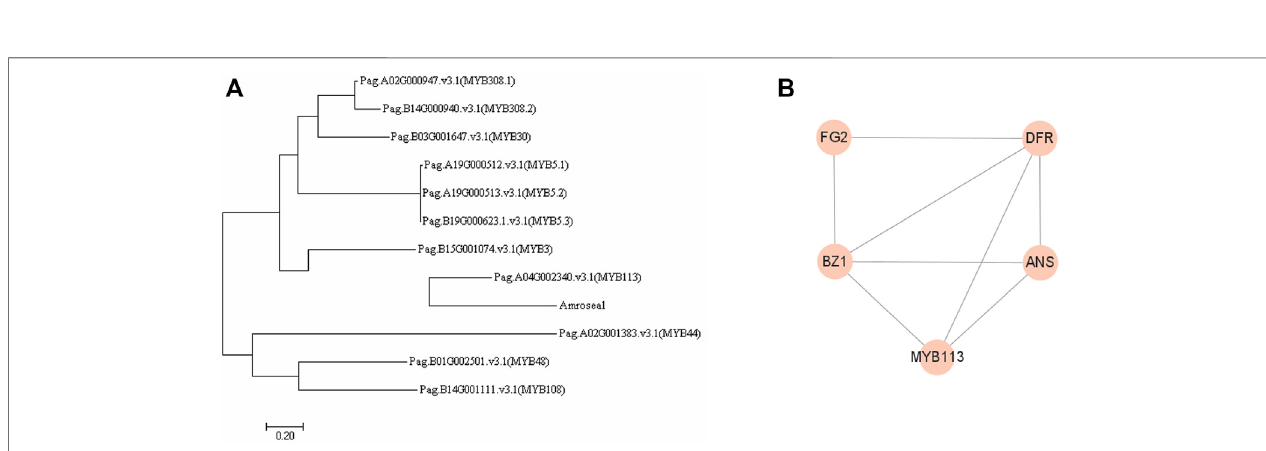
FIGURE 6 | Phylogenetic tree analysis and construction of co-expression network. (A) . The phylogenetic tree between MYBs and AmRosea1 using MEGA seven software. (B) . The co-expression network of MYB113 used String (https://cn.string-db.org/).